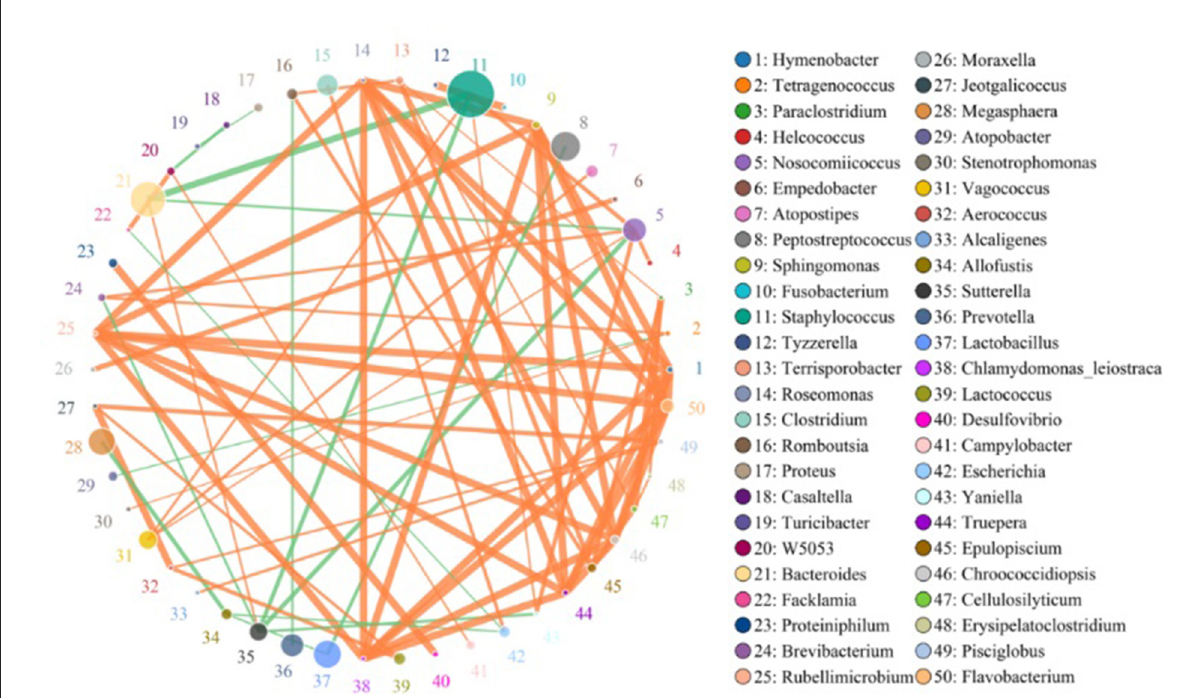
FIGURE4 Species network at the genus level. Circles represent species; the size of the circle represents abundance; edges represent the correlation between the two species; thickness of the edge represents the strength of the correlation; and the color of the line represents correlation: orange represents positive correlation, while green represents negative correlation.